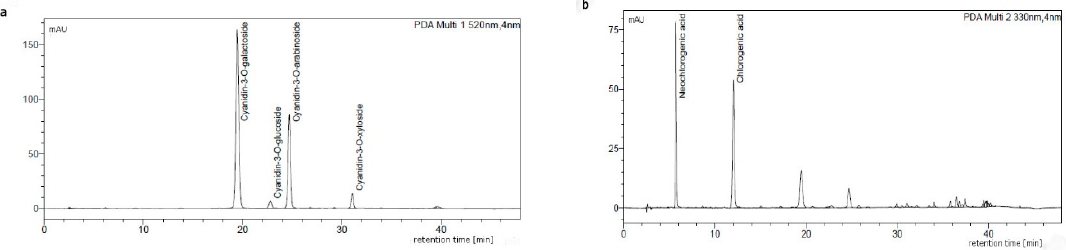
Figure 1. Composition of chokeberry dry extract from batch B1, separated by using HPLC recorded at ( a ) 520 and ( b ) 330 nm.